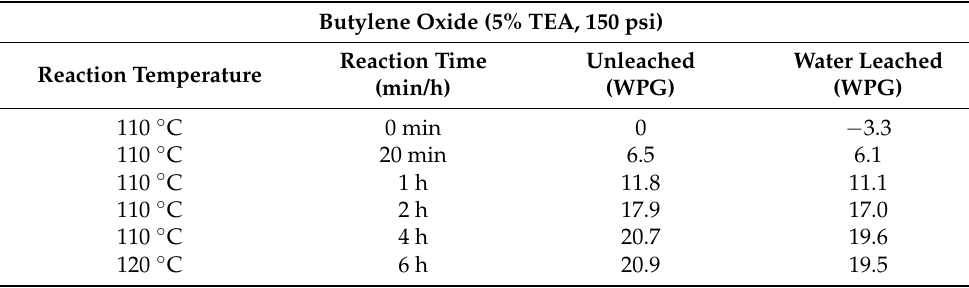
Table 1. Weight percent gain of BO modified wood fiber before and after water leaching.